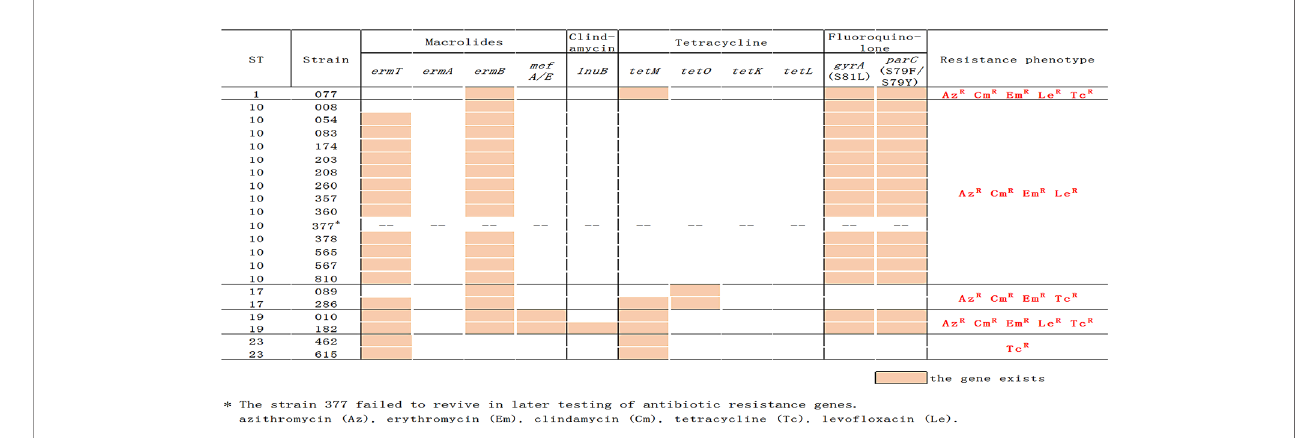
FIGURE 3 | Distribution of antibiotic resistance gene and phenotypes in the GBS